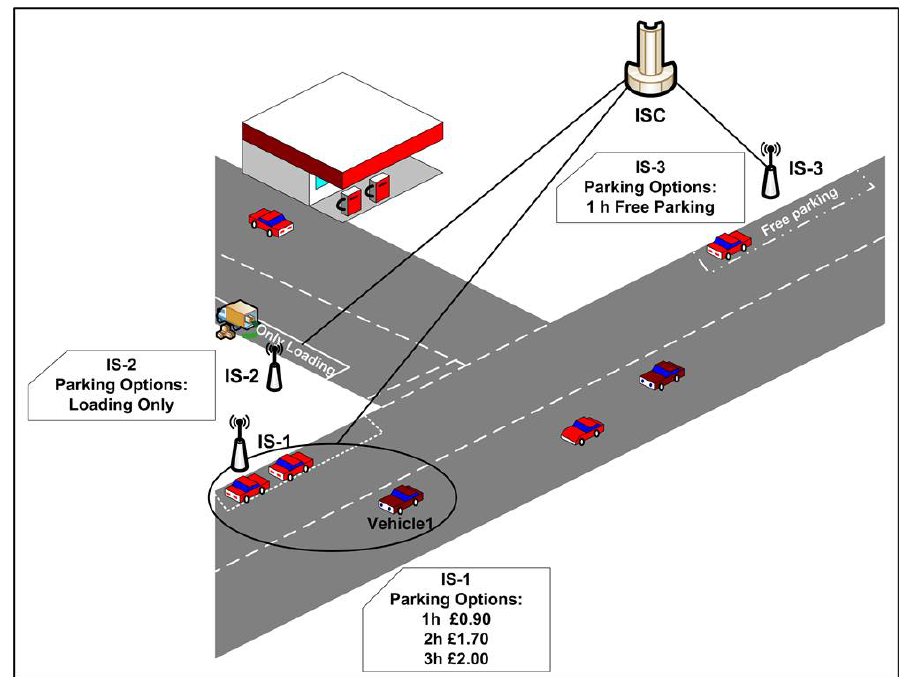
Figure 1. On-street parking system